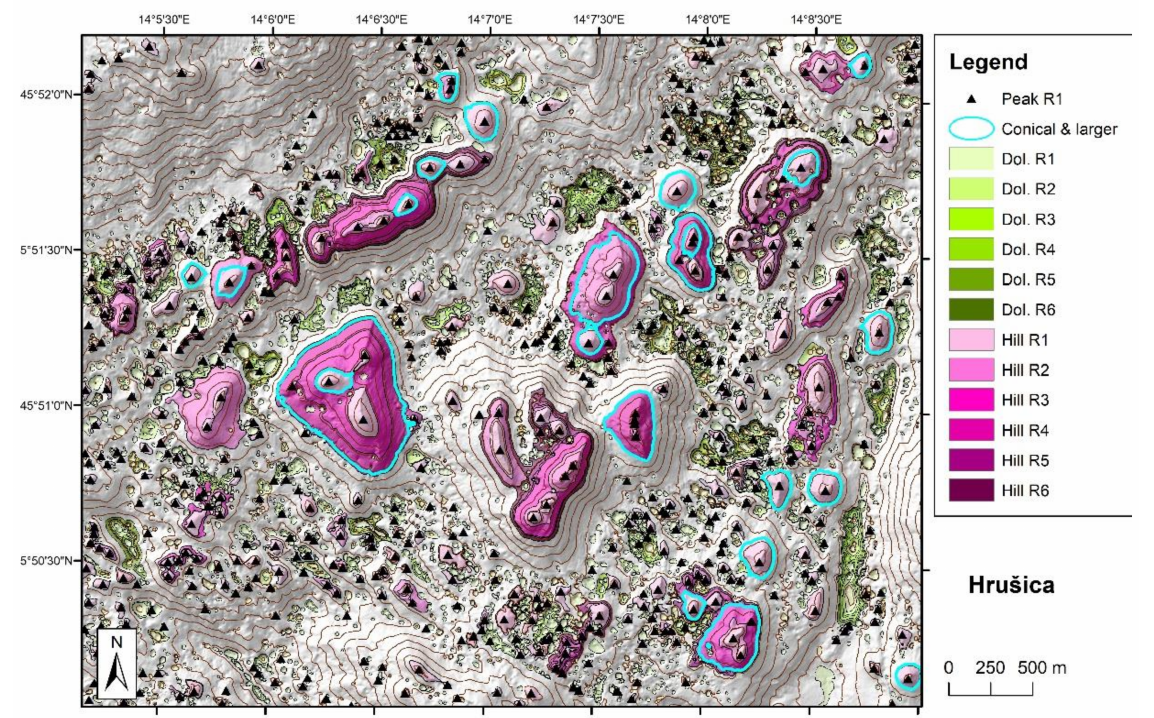
Figure 4. Hillshade map of the Hrušica study area with dolines and karst hills of different ranks. Hills highlighted by cyan outlines are the more circular and larger conical hills (circularity > 0.7, height > 20 m). For further explanation see the Results section in text. Contour interval is 10 m.